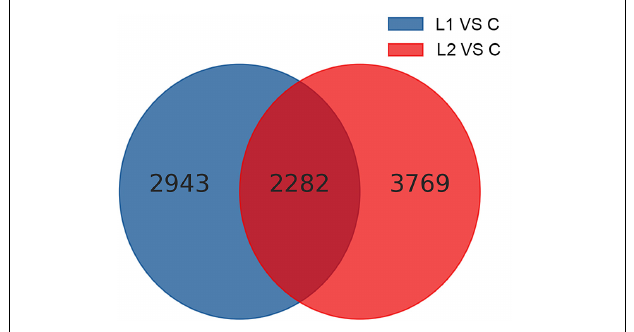
FIGURE 5 | Common and unique differentially expressed genes among different comparison